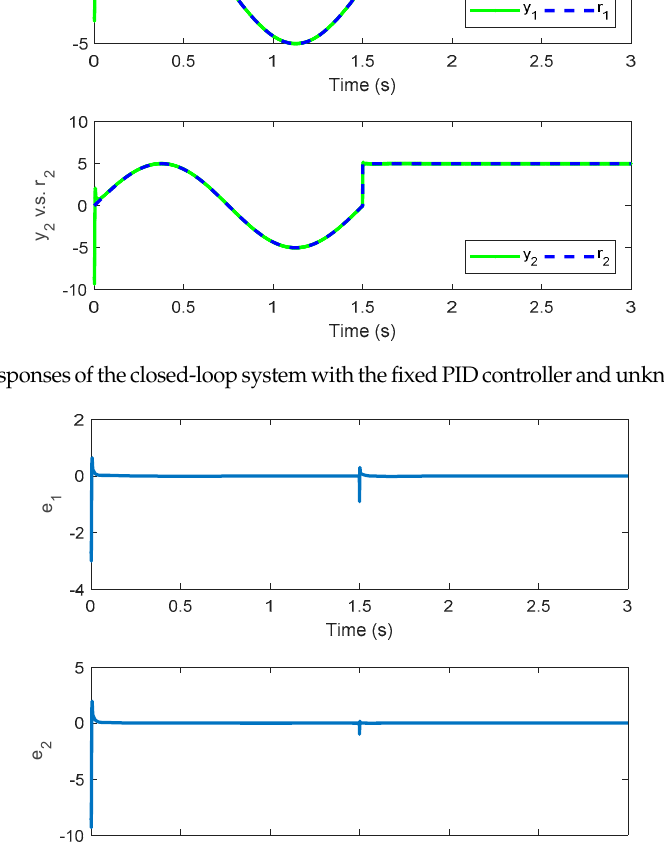
Figure 3. Tracking errors of the closed-loop system with the fixed PID controller and unknown perturbation.